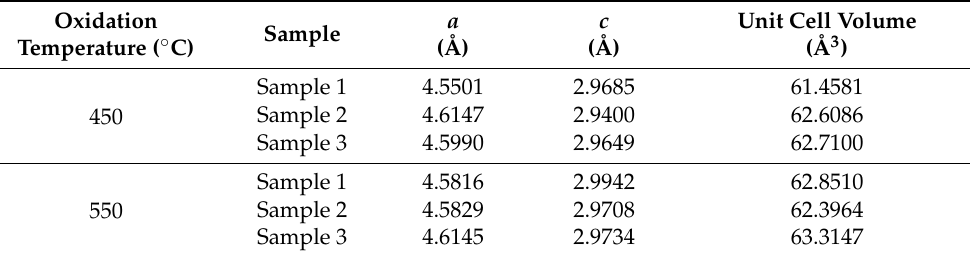
Table 1. Optimized lattice parameters of the rutile phase in Ti-TiO 2 bilayer thin-film samples as a function of oxidation temperature.